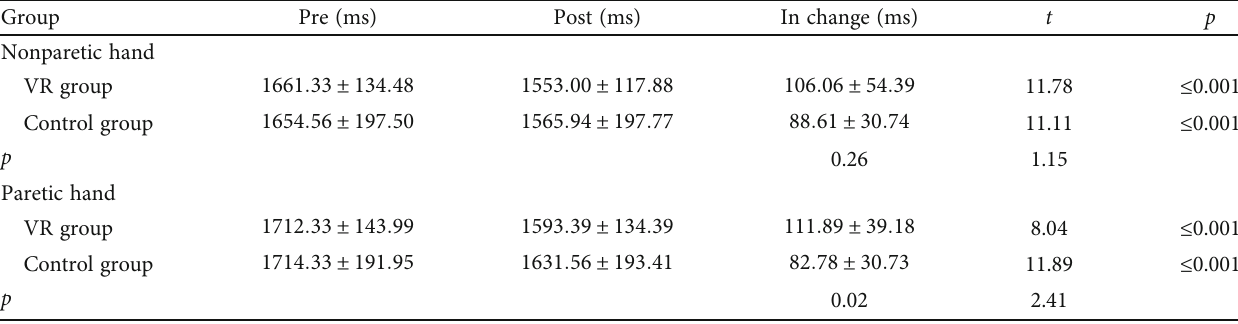
Table 2: Comparison of EMG onset time before and after intervention during nonparetic and paretic hand movements. Group Pre (ms) Nonparetic hand Control group Paretic hand